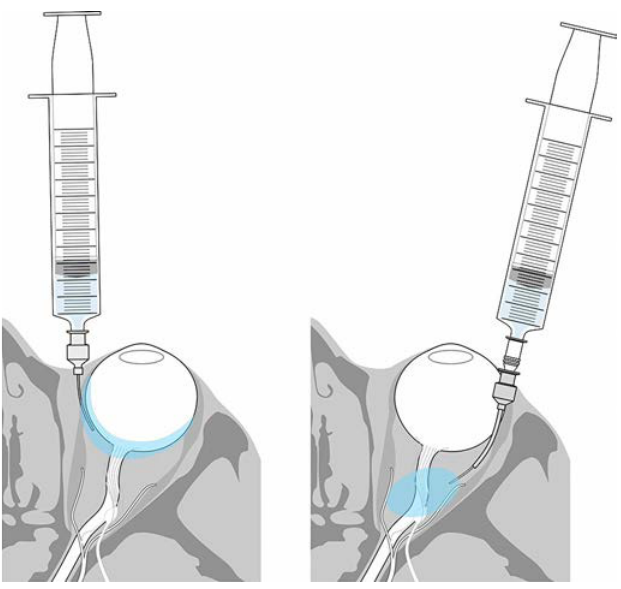
Figure 1 Procedures for induction of sub-Tenon’s capsule anesthesia (STA; left) and trans-Tenon’s capsule retrobulbar anesthesia (TTRBA; right). For STA, the sclera was exposed by an incision made in the conjunctiva and Tenon’s capsule in the inferonasal area. A 25-gauge dull needle designed for STA was inserted between the sclera and Tenon’s capsule; 3 mL of 2% lidocaine were injected below Tenon’s space. For TTRBA, the sclera was exposed in the inferotemporal area; a 23-gauge cannula designed for TTRBA was then inserted between the sclera and Tenon’s capsule. A 25-gauge sharp (50-mm) needle was then inserted in the cannula and 3 mL of 2% lidocaine were injected into the